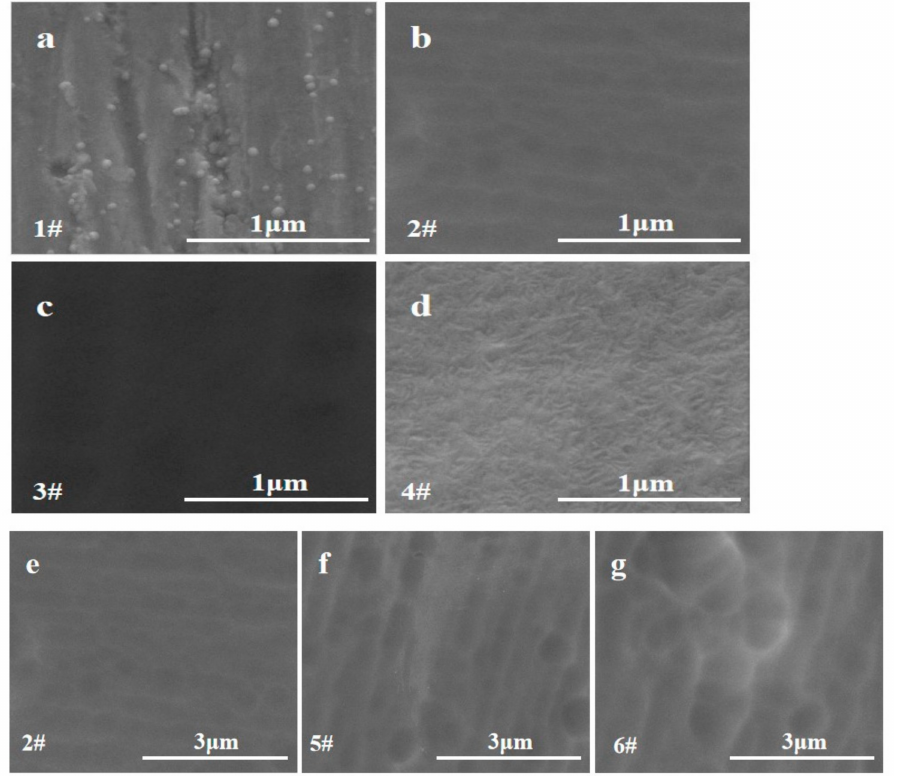
Figure 3. The SEM images of various Cu/Ti composite coatings: ( a ) 1#, ( b ) 2#, ( c ) 3#, ( d ) 4#, ( e ) 2#, ( f ) 5#, ( g )